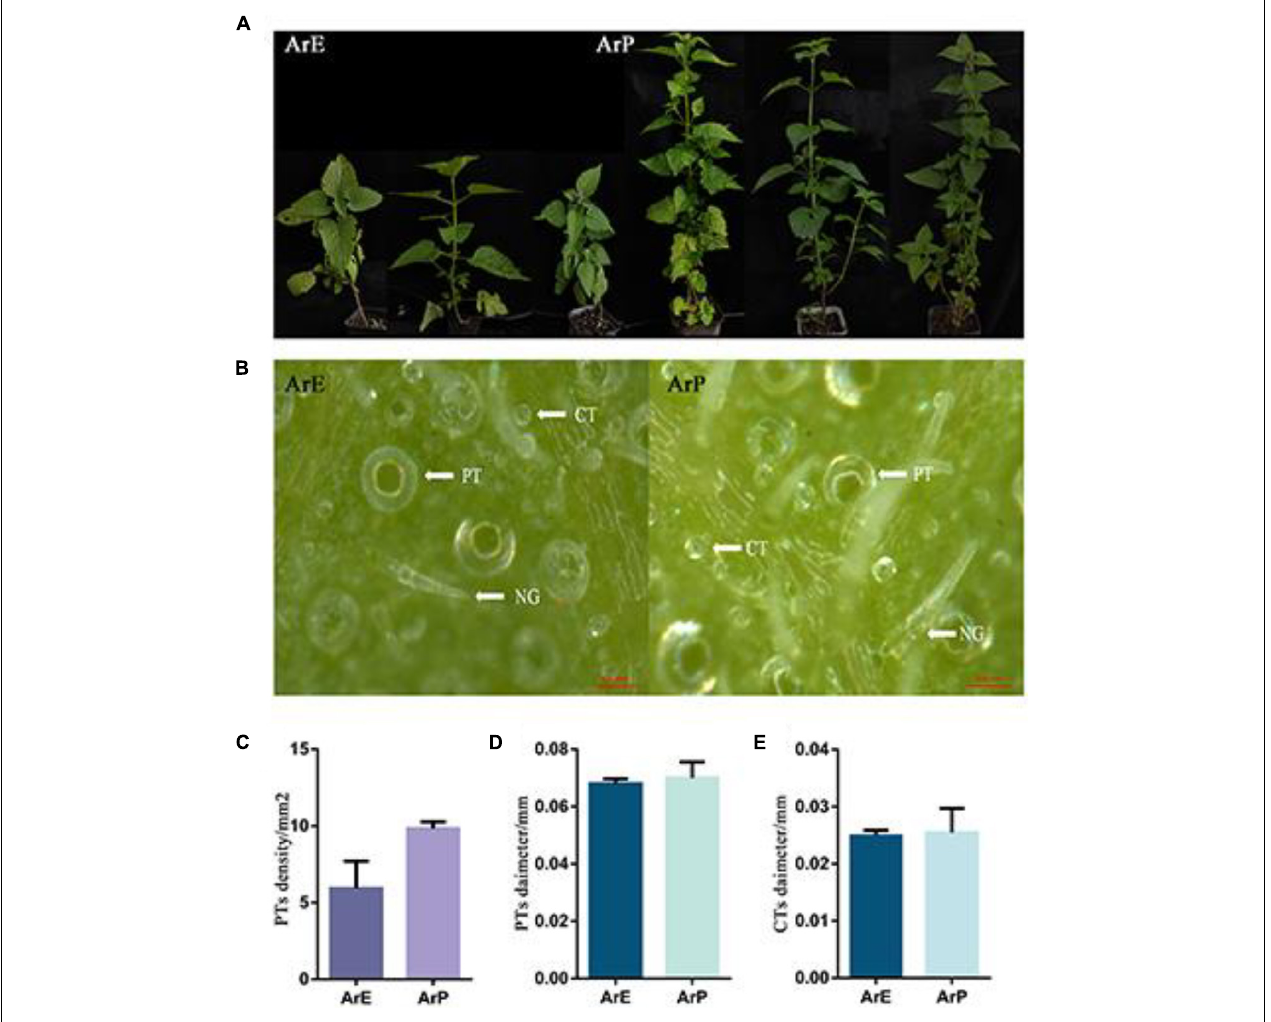
FIGURE 1 | Morphological characterization of ArP and ArE of A. rugosa. (A) Photographs show three representative 12-week-old plants from the two chemotypes of A. rugosa . (B) Morphological features of trichomes on leaf surfaces, peltate trichome (PT), capitate trichome (CT), and non-glandular hairs (NG). (C) Peltate trichome density of ArE and ArP. Statistical significance was determined using the t -test ( P < 0.05). (D) Peltate trichome diameter of ArE and ArP. Statistical significance was determined using the t -test ( P > 0.05). (E) Capitate trichome diameter of ArE and